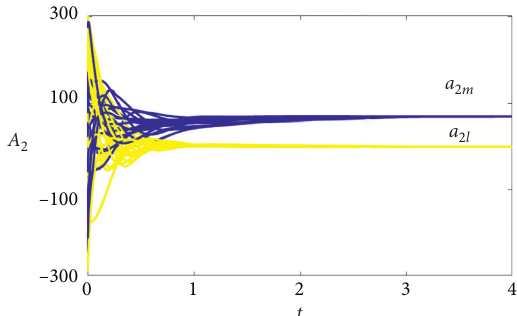
, a , a , a ,a and a for neural network (53) and (54) in Example 9. 0 l 1 l 2 l 3 l 4 l 5 l